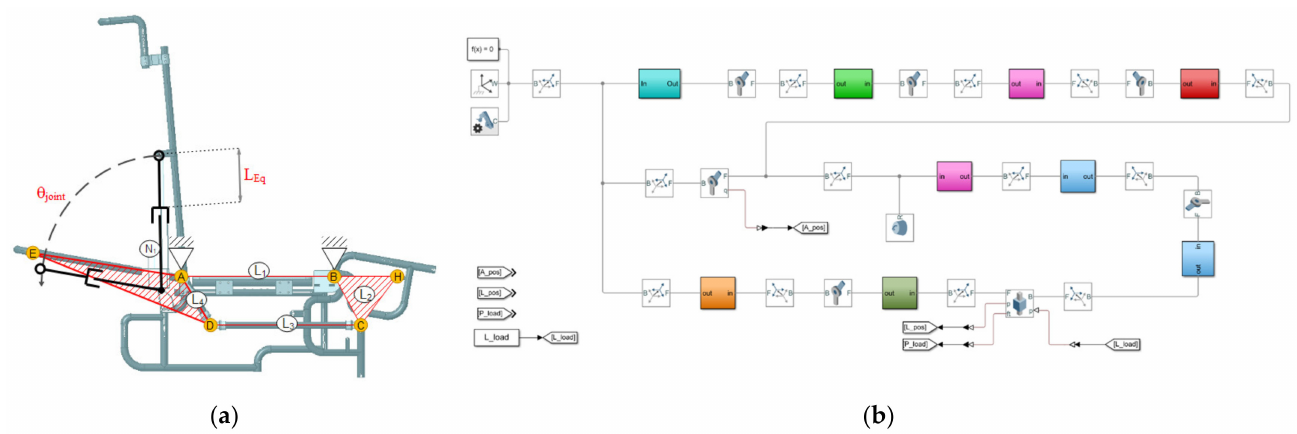
Figure 5. Wheelchair mechanism parts: ( a ) Wheelchair links and actuator ( b ) Wheelchair multibody diagram for posi- tion